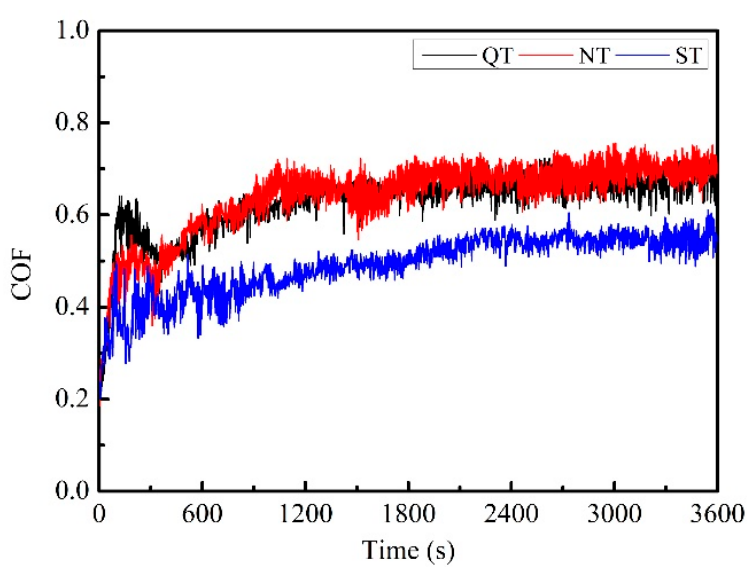
Figure 8. COF at the midpoint of the wear track as a function of test time for QT, NT, and ST.